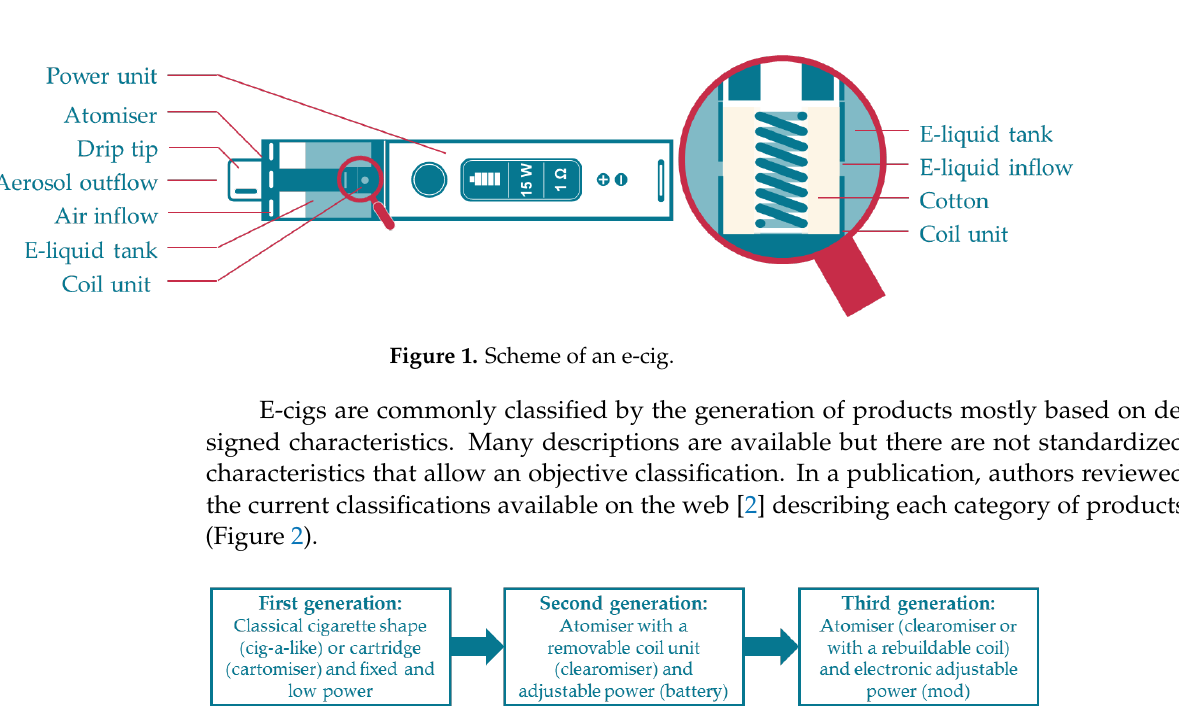
Figure 1. Scheme of an e-cig.